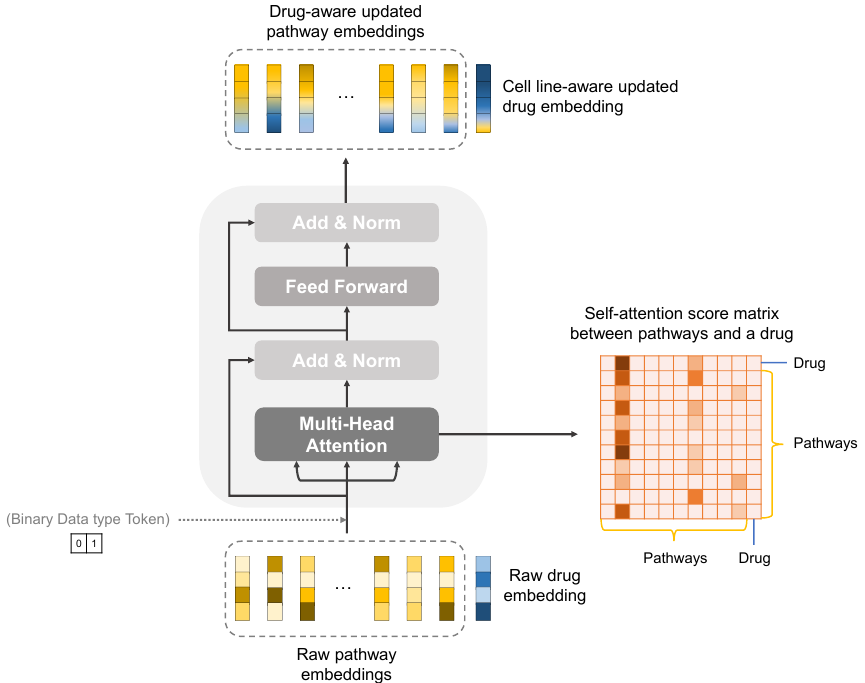
Figure 3. A detailed structure of type-aware transformer encoder reflecting interactions and relation- ships between pathways and a drug. We extracted drug-pathway interaction information from the modified encoder of the Transformer module and identified putative key pathways for the drug’s mechanism of action using a matrix of self-attention scores between pathways and the